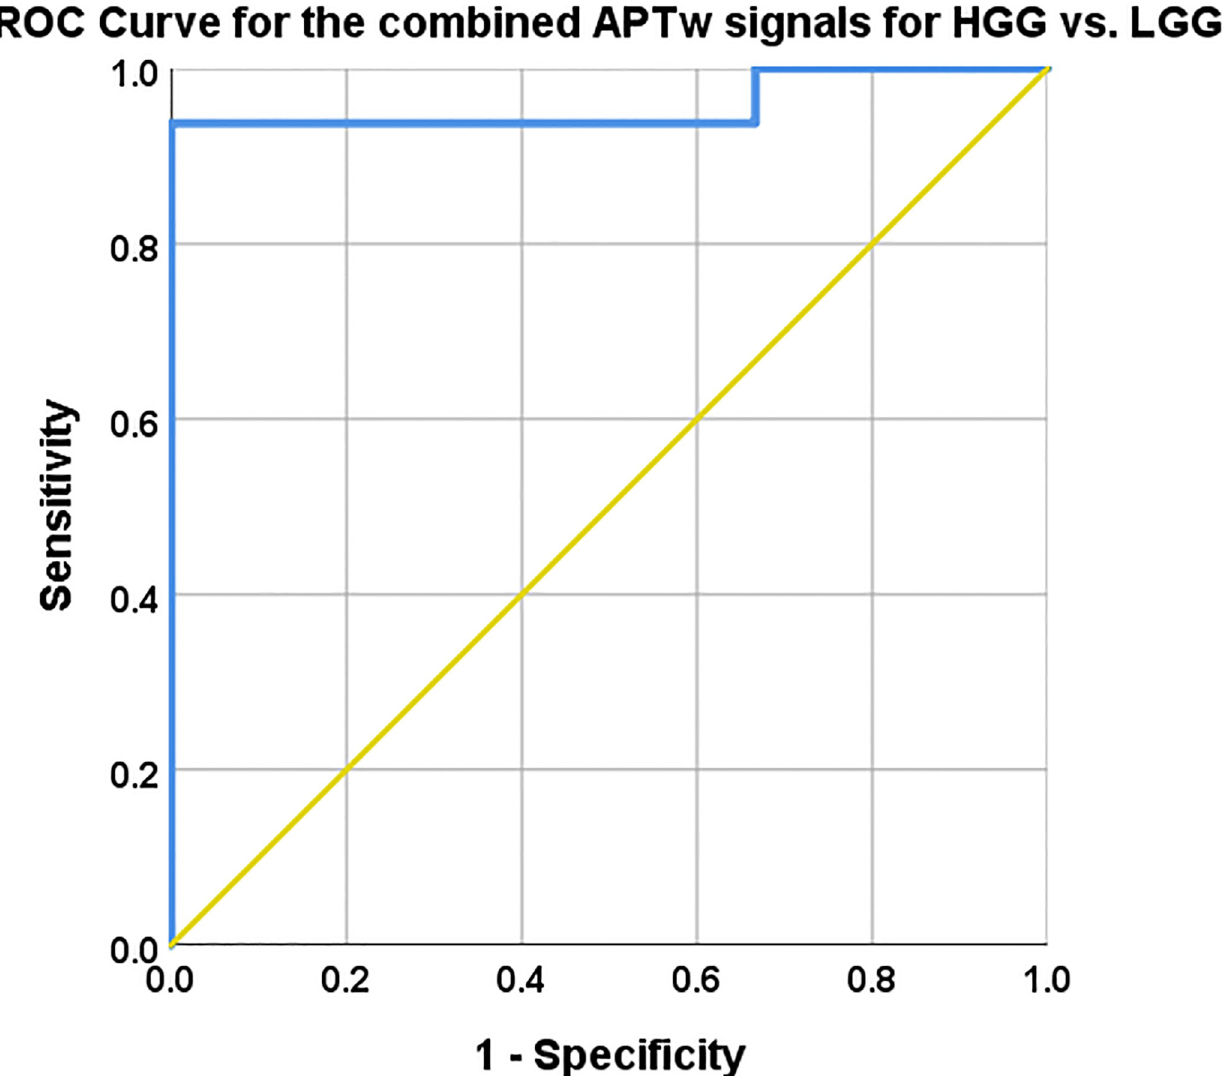
Fig 7. Mean, max and range APTw signal combined with logistic regression. AUC, 95% CI, Sensitivity and specificity with cut off values reported in Table 4. The combined model mislabelled subjects 3 and 17 as they were labelled HGG in the model but are histologically verified LGG, also subject 7 was mislabelled as a LGG whereas it is histologically a Glioblastoma, Table 1.